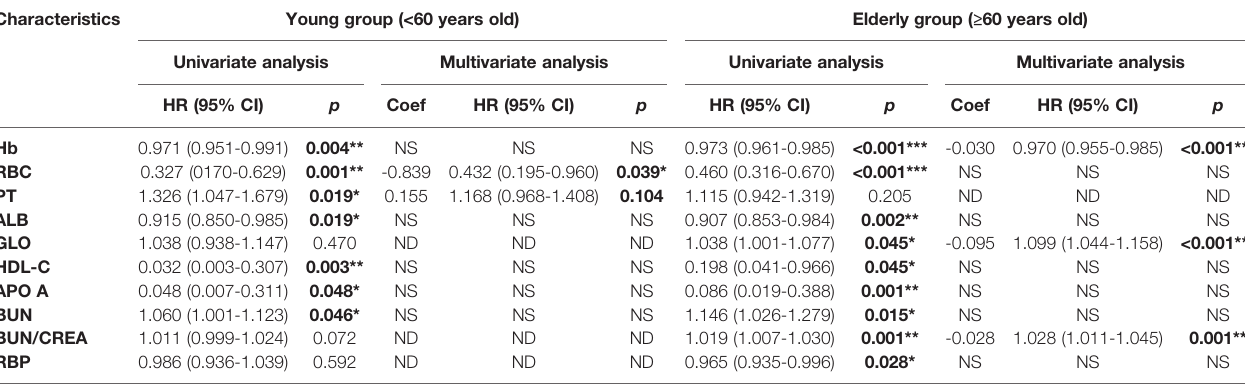
TABLE 3 | Univariable and multivariable analyses of OS in young and elderly CLL patients.